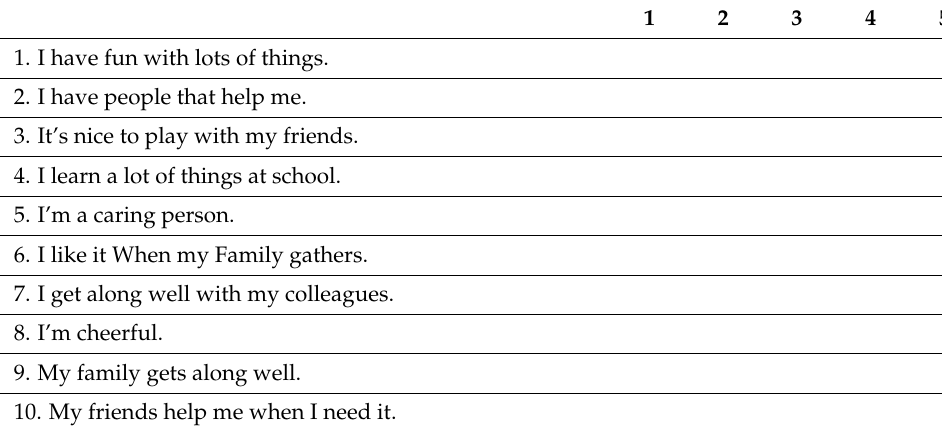
Table A1. Data collection instrument for the Multidimensional Life Satisfaction Scale for Children (EMSVC)—Reduced